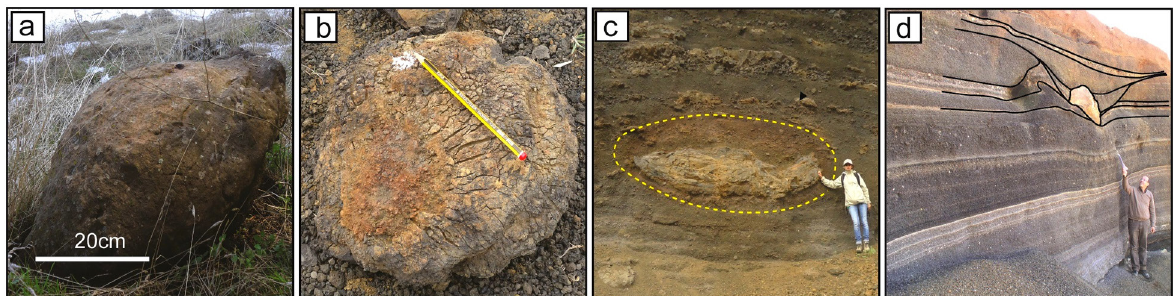
Fig. 5. Eruptive deposits from Strombolian cones. a) Spindle-bomb occurring on the northern flank of Jbel Habri. b) Bread-crust bomb occurring at the Strombolian base of west Hebri